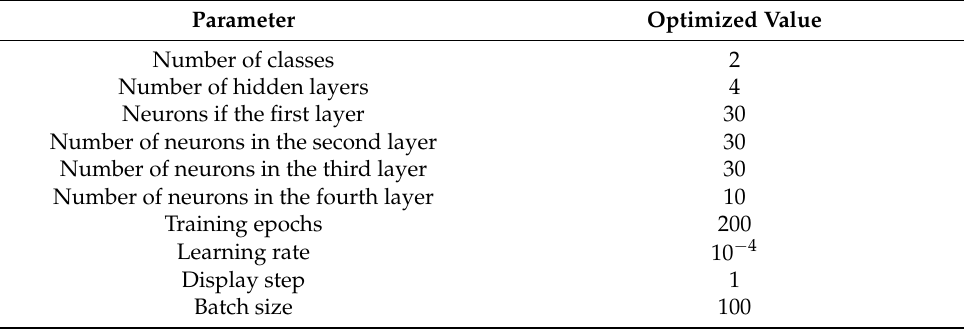
Table 10. The optimized parameters of the developed neural network employed in monkeypox classification using